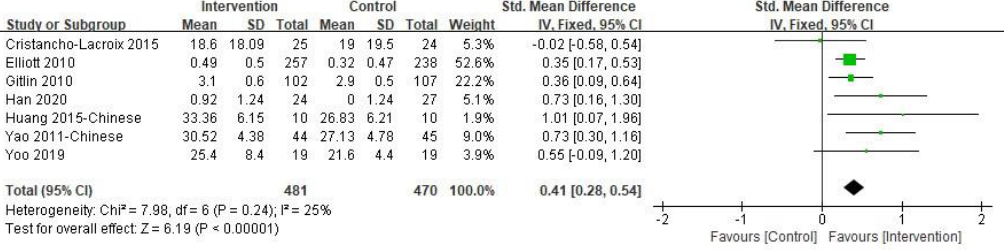
Figure 2. Effect of multi-component interventions on informal caregiver’s subjective well-being (post-intervention).